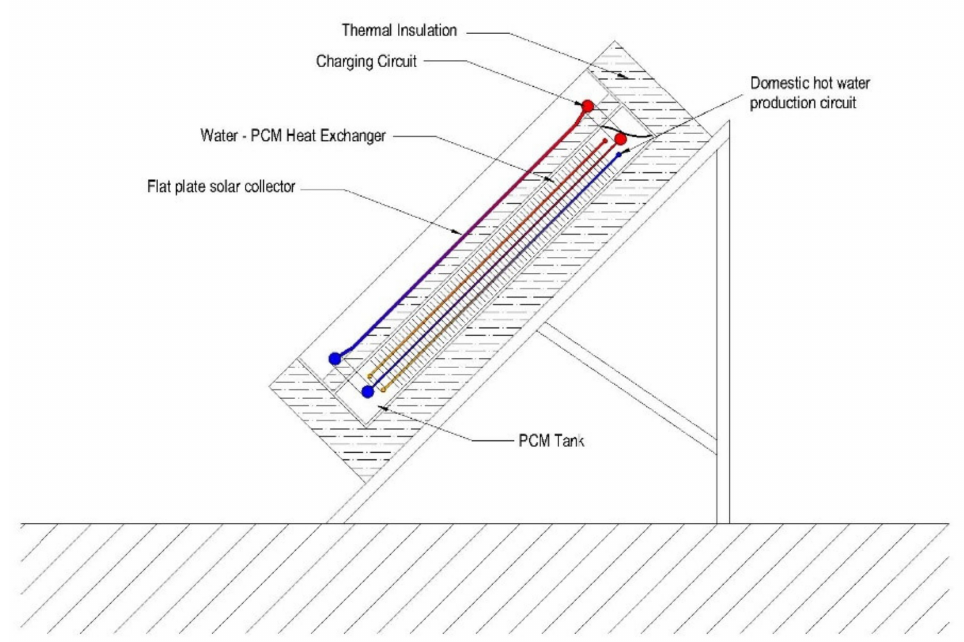
Figure 1. View of Solar Kit collector (cross section).